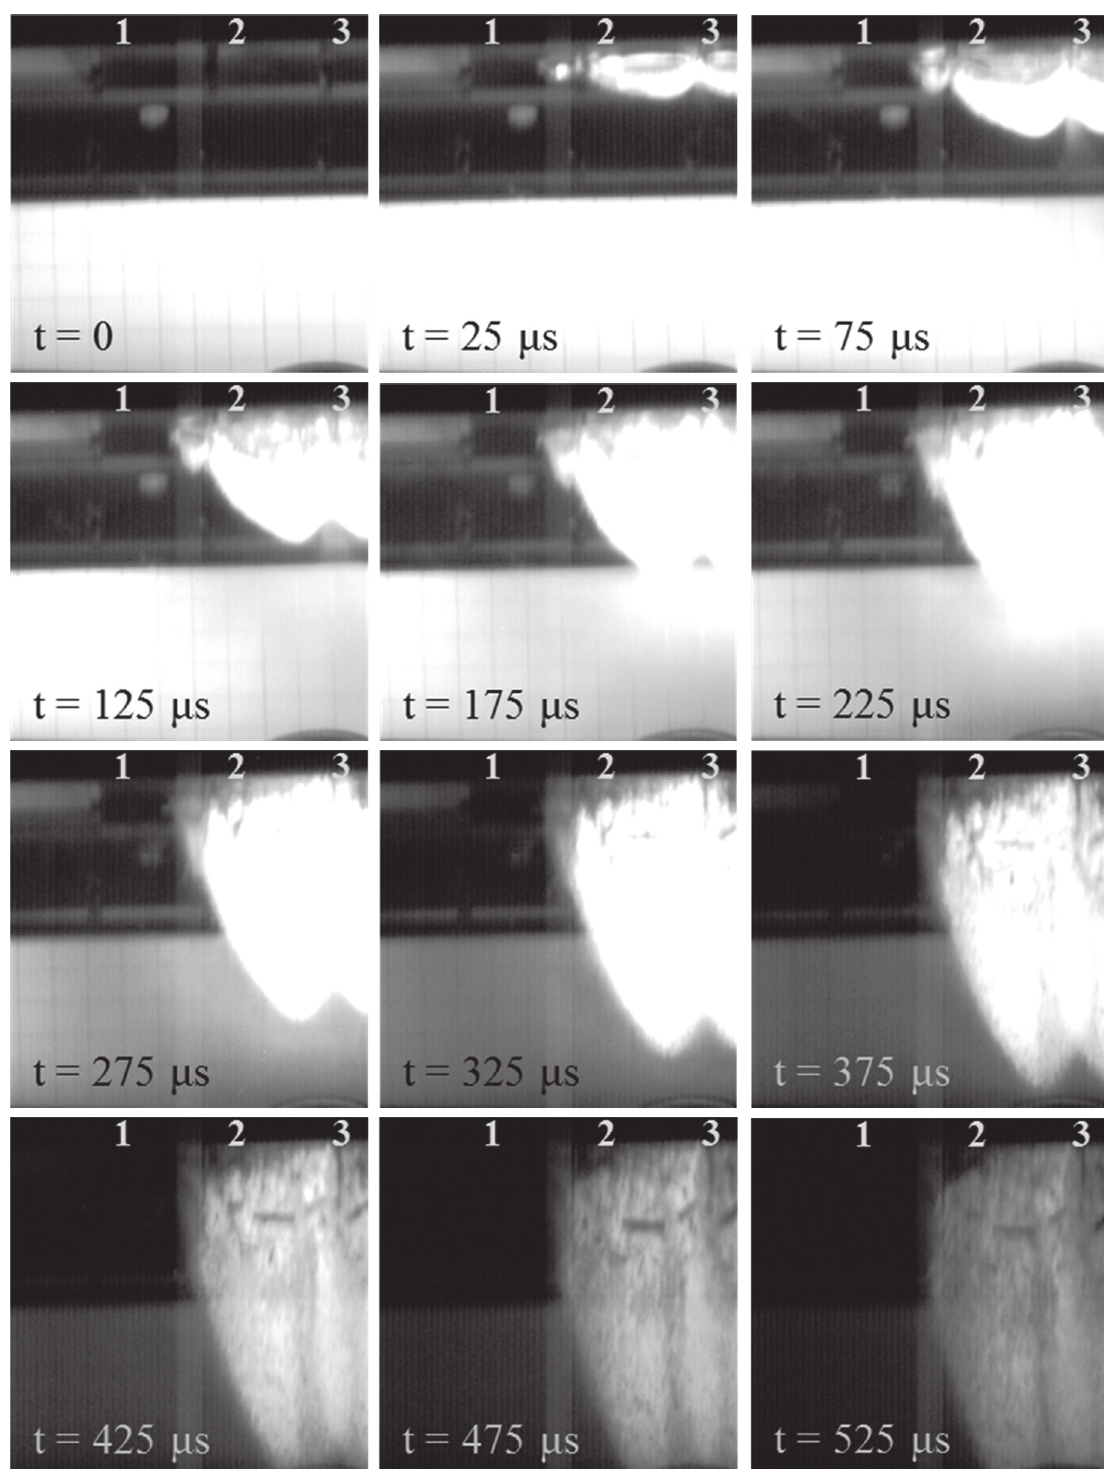
Figure 26: Image sequence of the impact on Inermet ® 180 of a 72 bunches proton pulse. Beam is coming from the left; three Inermet samples are partially visible (numbered 1 to 3) [29]. (a) t � 0. (b) t � 25 µ s. (c) t � 75 µ s. (d) t � 125 µ s. (e) t � 175 µ s. (f) t � 225 µ s. (g) t � 275 µ s. (h) t � 325 µ s. (i) t � 375 µ s. (j) t � 425 µ s. (k) t � 475 µ s. (l) t � 525 µ